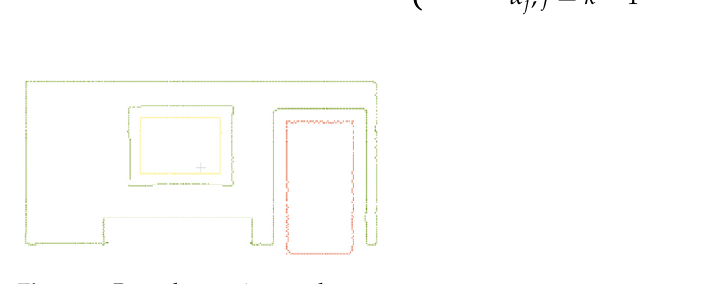
Figure 6. Boundary point result.